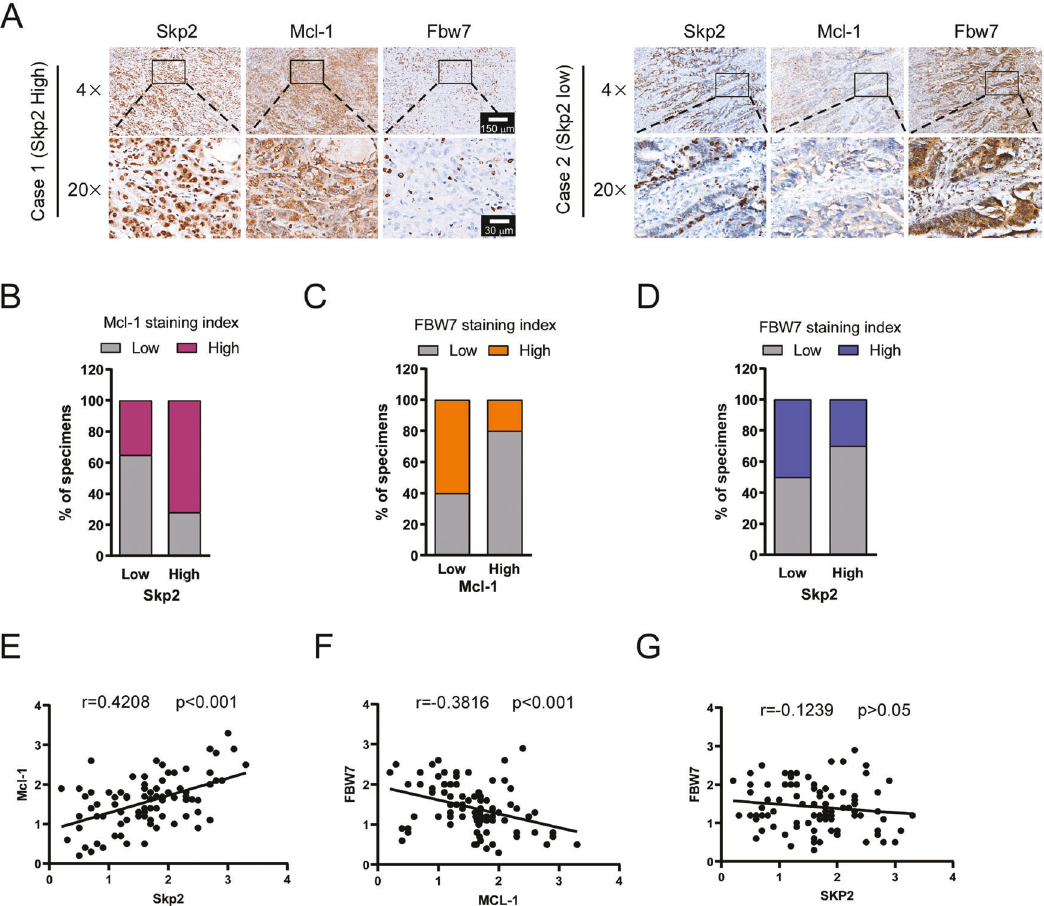
Fig. 7 Skp2 positively correlates with Mcl-1 in CRC tissues. A representative cases from 87 CRC specimens were analyzed by IHC staining with Skp2, Mcl-1, and FBW7. B The percentage of samples displaying low or high Skp2 expression compared to the expression levels of Mcl-1. C The percentage of specimens displaying low or high Mcl-1 expression compared to the expression levels of FBW7. D The percentage of specimens displaying low or high Skp2 expression compared to the expression levels of FBW7. E Scatterplot showing the positive correlation between Skp2 and Mcl-1. F Scatterplot showing the negative correlation between Mcl-1 and FBW7. G Scatterplot showing no correlation between Skp2 and